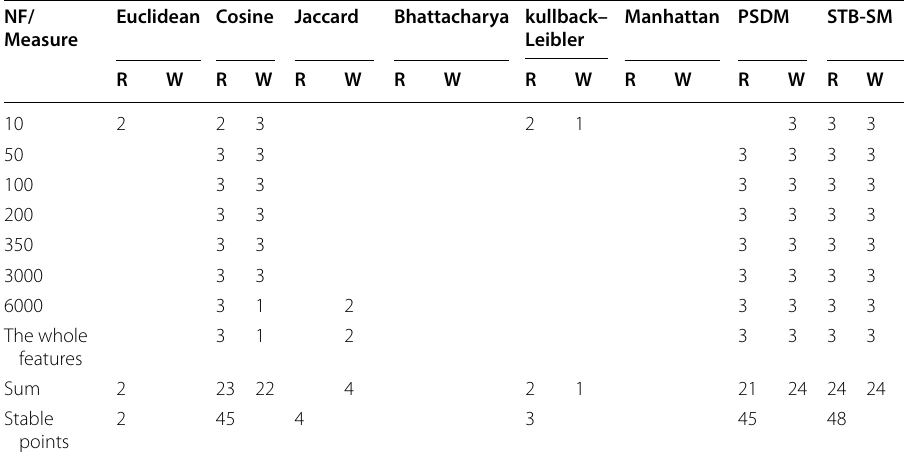
Table 19 Measure stability